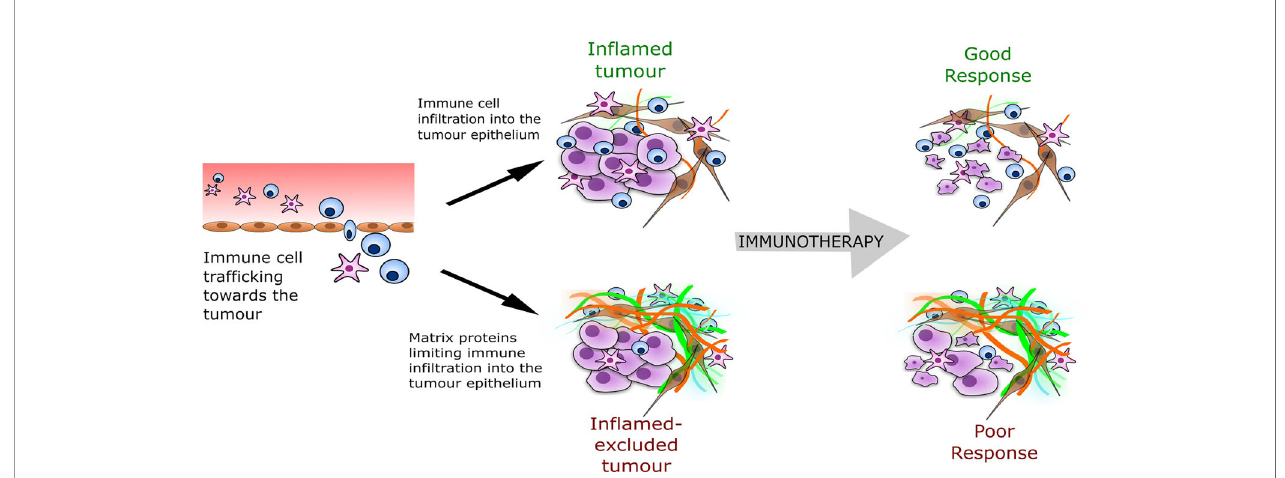
FIGURE 1 | The tumour immune phenotype and predicted response to immunotherapy. The in fl amed-excluded phenotype is de fi ned through less interaction or contact of cytotoxic immune cells (CD8+ T-cells, natural killer cells) with the tumour epithelial compartment, which may result from a barrier formed from a particular composition of tumour ECM (shown as the orange and green fi bres in the illustration above). The ECM barrier reduces immunotherapy